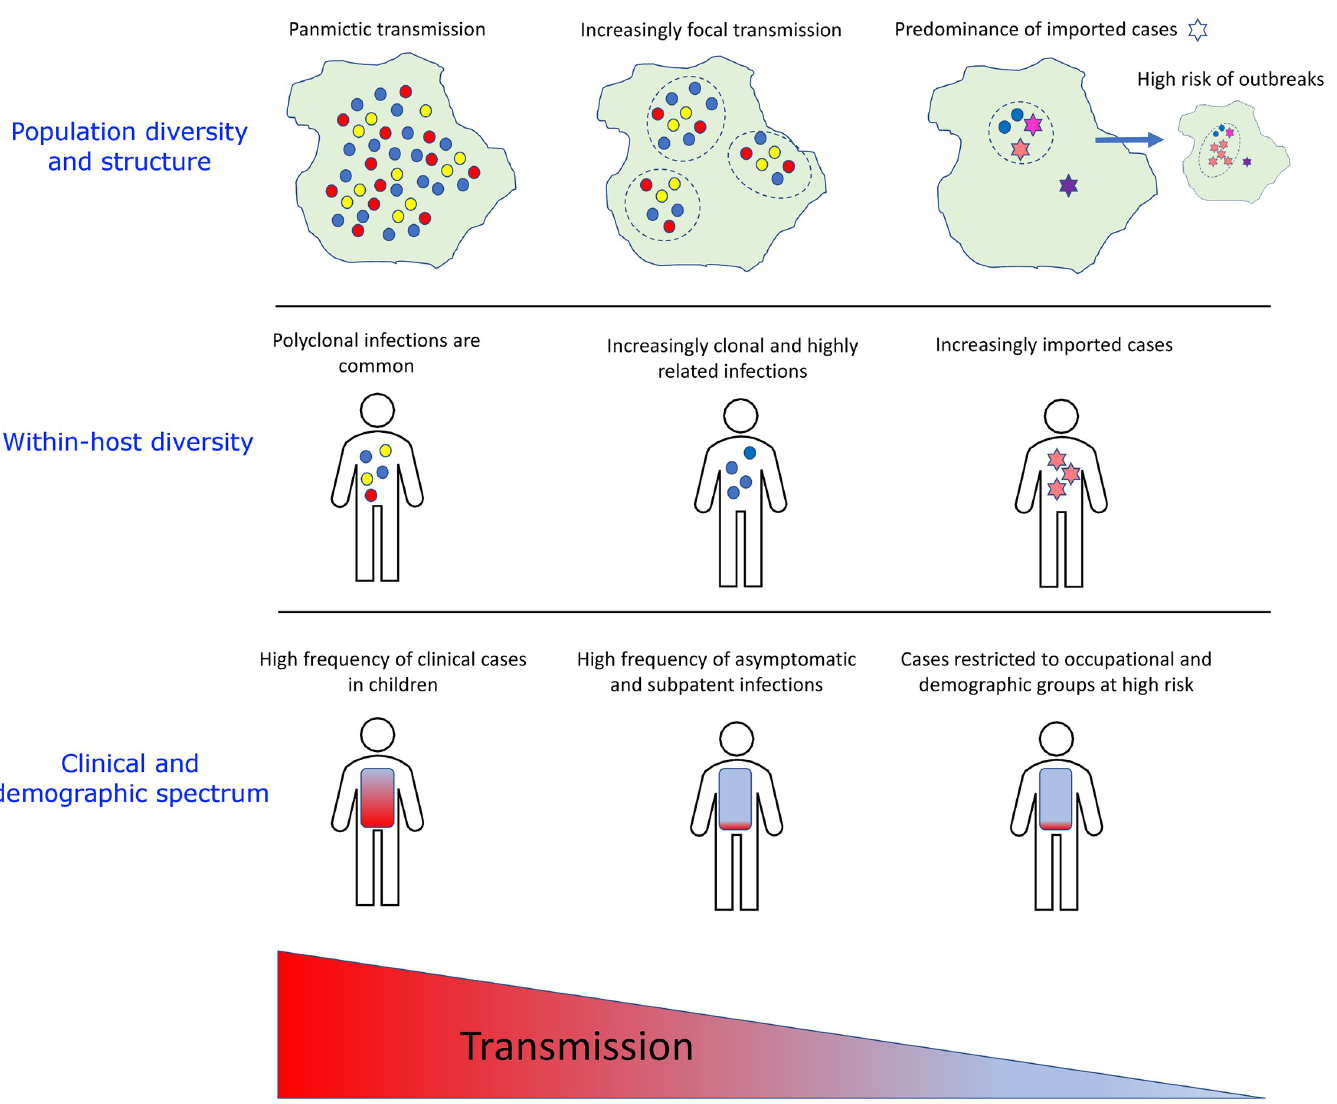
Fig 1. Trends in parasite transmission and diversity, with the spectrum of clinical illness and demographics varying with endemicity. The schematic was inspired by Fig 1 in Wesolowski et al. [36]. As transmission declines, parasite populations become increasingly fragmented into distinct foci and enhanced inbreeding leads to clonal and highly related infections. An increasing proportion of infections are acquired from importations, with high risk of outbreaks. Cases become harder to detect and treat owing to increasingly asymptomatic outcome and SM level. A shift is also observed towards high-risk occupational groups and hard-to-reach populations. S AU : AbbreviationlistshavebeencompiledforthoseusedthroughoutFigs 1 and 2 : Pleaseverifyiftheentriesarecorrect : M,